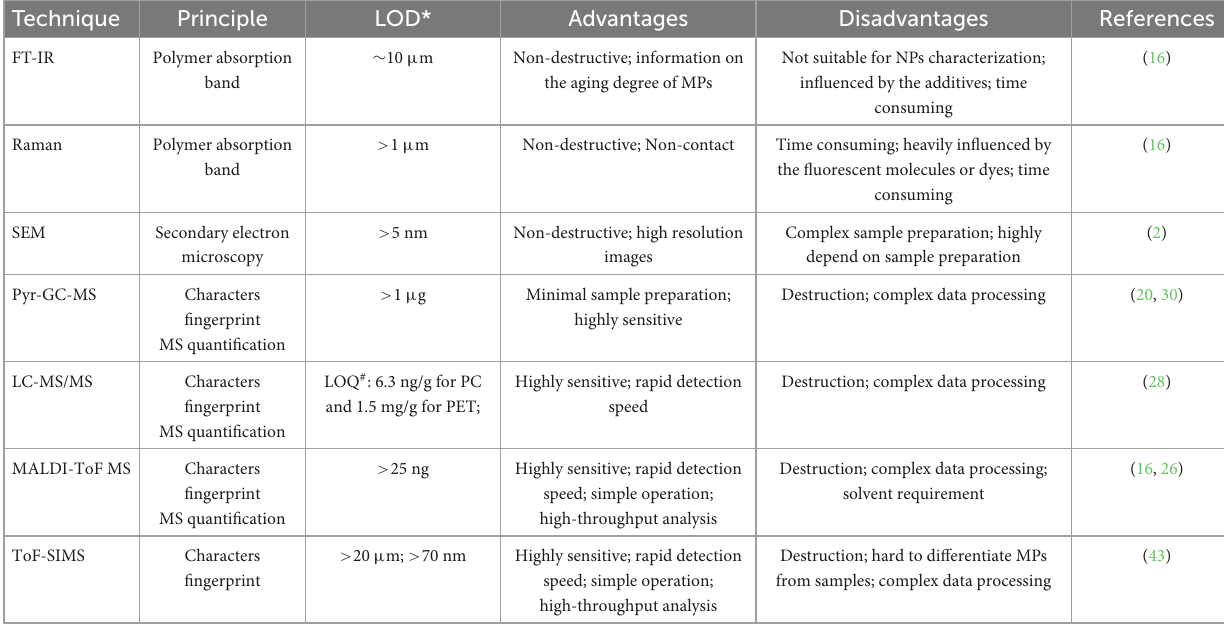
TABLE 2 Advantages and disadvantages of MS technique in MPs